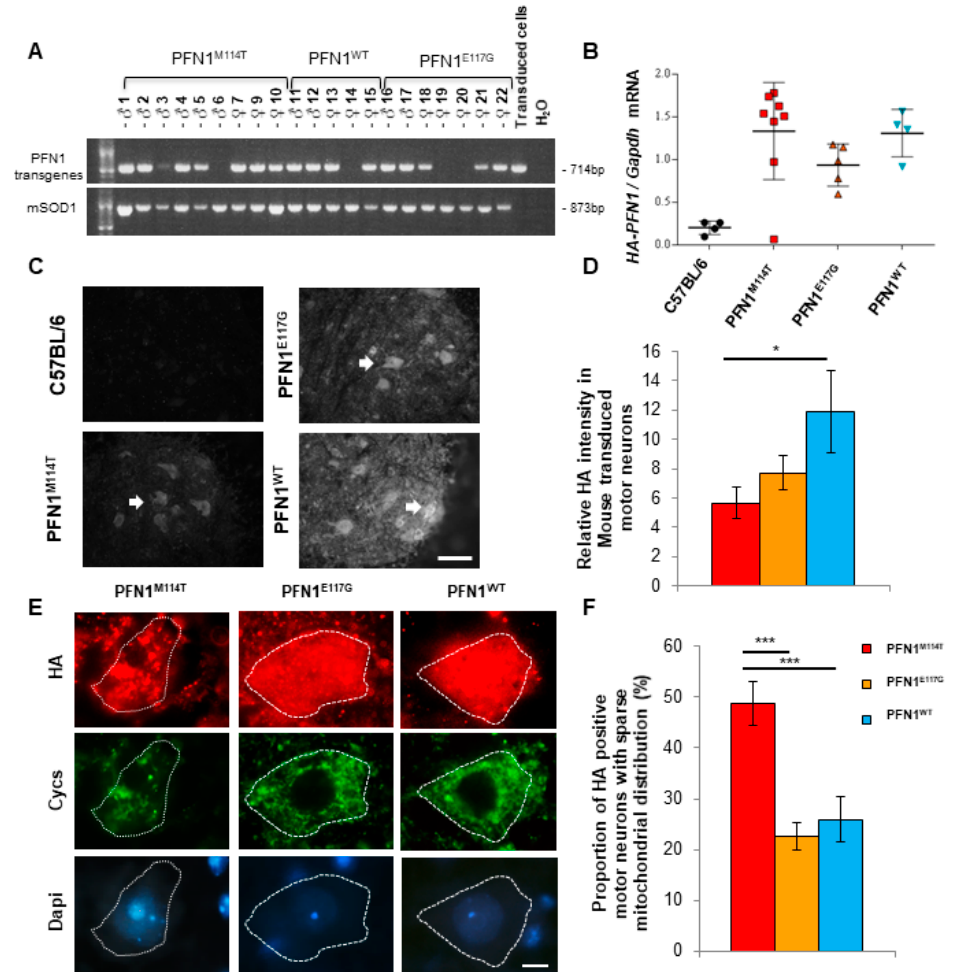
Figure 5. Instability of M114T PFN1 protein and histological analyses in PFN1 mouse spinal cord. ( A ) PCR were performed on DNA extracted from tail fragments with primers specific for PFN1 transgene and Sod1 fragment as a marker of DNA quality. ( B ) Semi-quantitative mRNA determination for HA-tagged PFN1 transgenes related to that of Gapdh for C57Bl/6 (black circles), PFN1 M114T (red squares), PFN1 E117G (orange triangles) and PFN1 WT (blue inverted triangles) mice. Note that mice with no transgene detected in A (mice 6, 14, 19, 20) were not included in B. ( C ) Immunofluorescence analysis using anti-HA antibody was performed on lumbar spinal cord sections to detect the transgene in the C57BL/6, PFN1 M114T , PFN1 E117G and PFN1 WT mice. White arrows point to HA positive motor neurons. Bar: 40 µm. ( D ) The relative intensity of HA fluorescence measured in transduced motor neurons is lower in PFN1 M114T than in PFN1 E117G and PFN1 WT . ( E ) Double immunofluorescence staining was performed on lumbar spinal cord sections using anti-HA antibody to detect PFN1 transgene (in red) and Cycs (in green). Dapi stained large nuclei with intense nucleoli in motor neurons. Mitochondria were sparse in motor neurons overexpressing the PFN1 M114T transgene. Bar: 10 µm. ( F ) Proportion of HA positive motor neurons with sparse mitochondrial distribution in lumbar spinal cord for PFN1 M114T (red), PFN1 E117G (orange) and PFN1 WT (blue) groups of mice. * p < 0.05, *** p < 0.005.